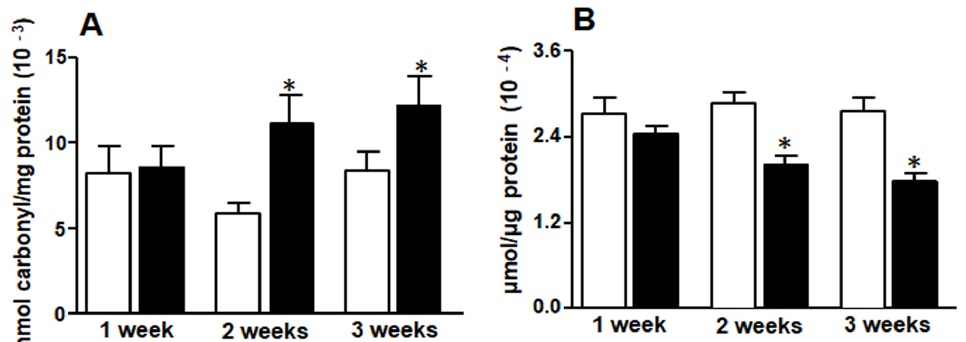
Figure 1. Liver protein carbonyl groups ( A ) and reduced glutathione (GSH) ( B ). White bars: control group (C rats), black bars: rats fed fructose-rich diet (FRD) (F rats). Values are expressed as means ± SEM ( n = 12 rats per group) * p < 0.05 compared to each control at each time point.